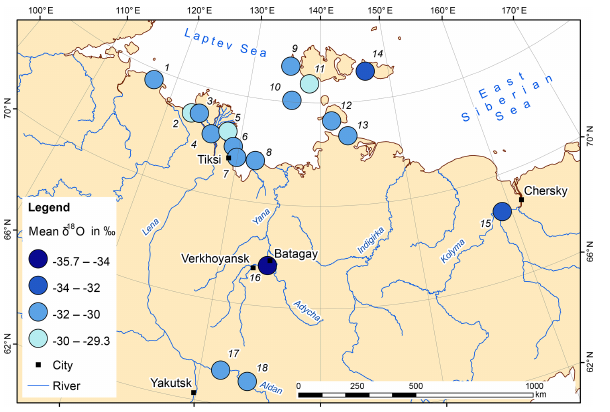
Figure 9. Map of mean d data from Siberian ice wedges attributed to the MIS 3 interstadial (about 50 to 30kyr). Site IDs are given in Fig. 7 and further details in Table